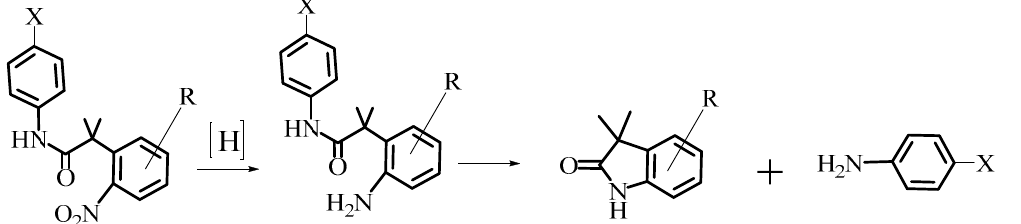
Figure 1. Multiple cell signaling pathways leading to MEK activation. GF: Growth Factor, RTK: Receptor Tyrosine